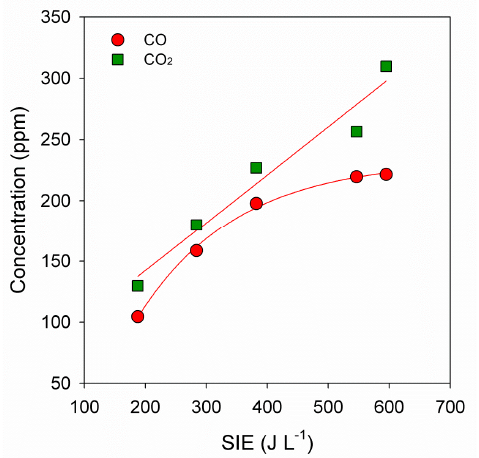
Figure 8. Outlet ozone concentration of hybrid Mn+(Mn-Fe) reactor and one-stage reactor with Mn/cordierite catalyst.